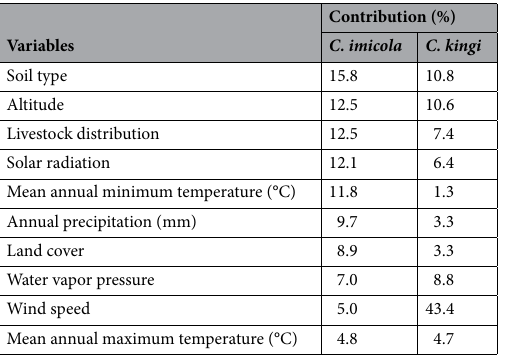
Table 6. Variables contribution in the predicted distribution of C. imicola and C.